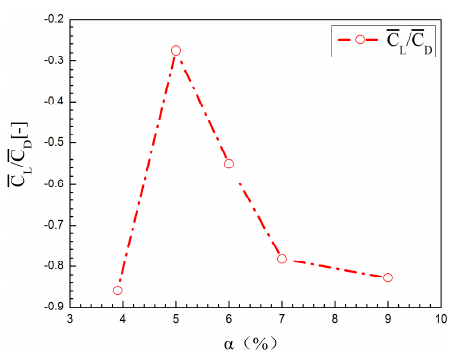
Figure 12. Variation of central rotating shaft lift-drag coefficient ratio with respect to different α .